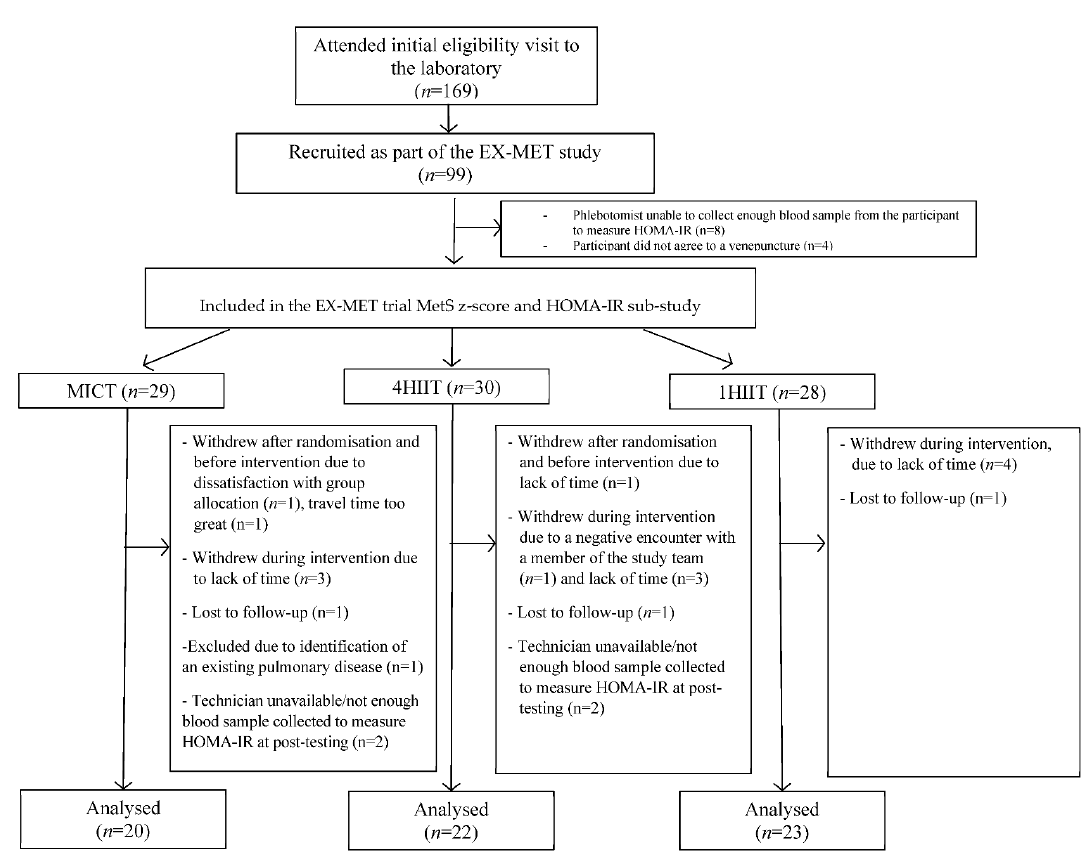
Figure 1. Participant flow chart. MICT, moderate-intensity continuous training; 4HIIT, 4 × 4 min high-intensity interval training; 1 × 4 min high-intensity interval training.